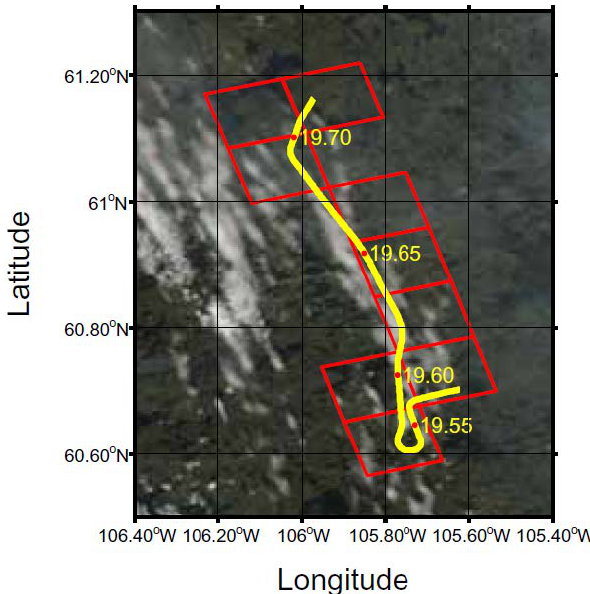
Figure 11. Overlay of MODIS RGB image with 10-km retrieval grid cell and P-3 flight track Fig. 11. Overlay of MODIS RGB image with 10km retrieval grid locations for Aqua overpass at 19.75 UT on 09 July 2008. cell and P-3 flight track locations for Aqua overpass at 19.75UT on 9 July